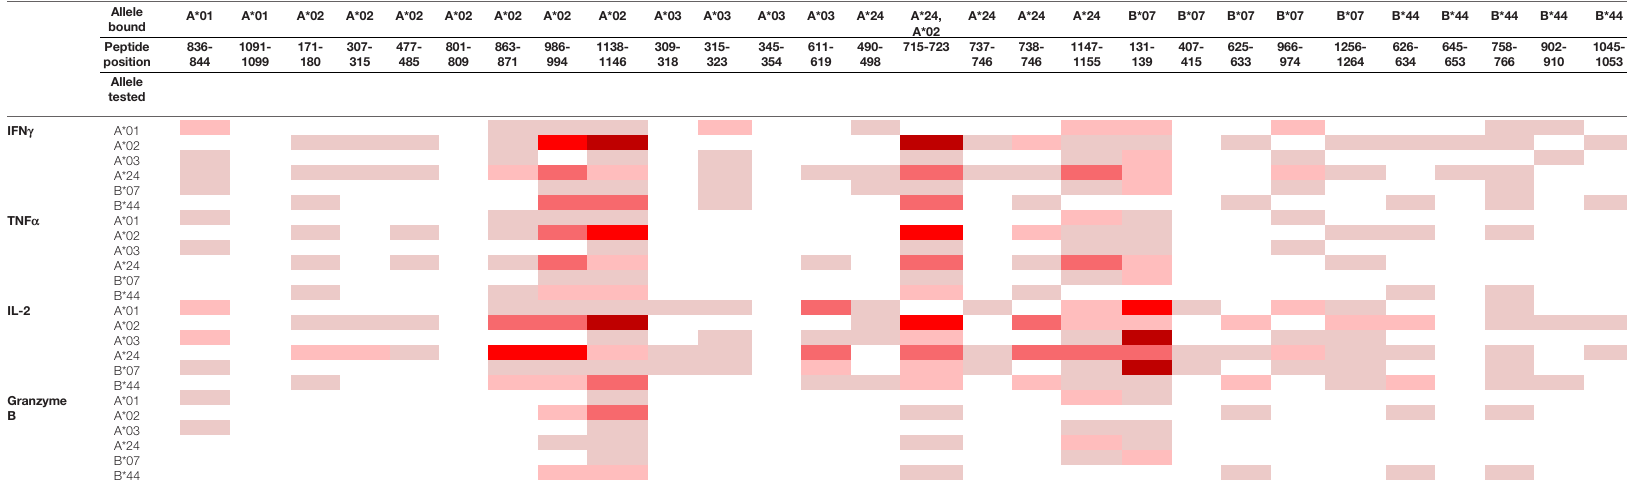
TABLE 4 | Summary of immune response to the class I peptides for PF14_0593 by different donor HLA supertypes. Allele bound